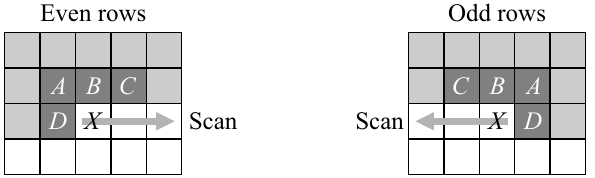
Figure 4. The neighbourhood of the current pixel, X , shaded dark. Shaded pixels have already been processed. Labelling is dependent on the scan direction. Algorithm 1 Zig-zag CCA